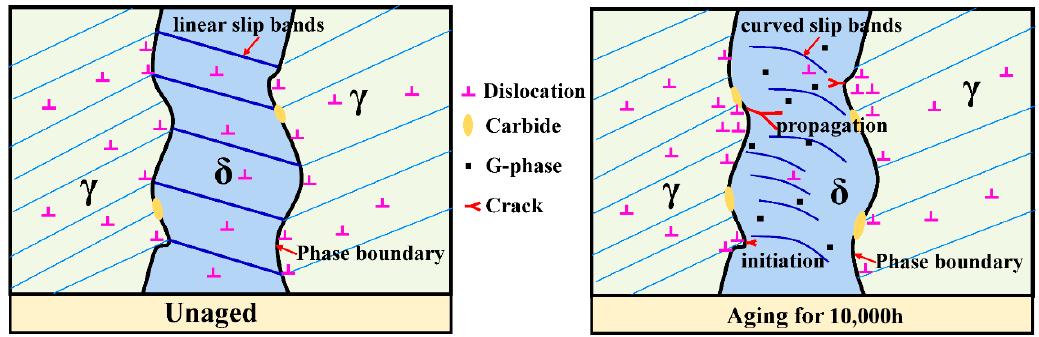
Figure 9. The crack initiation and propagation mechanism of CDSS.